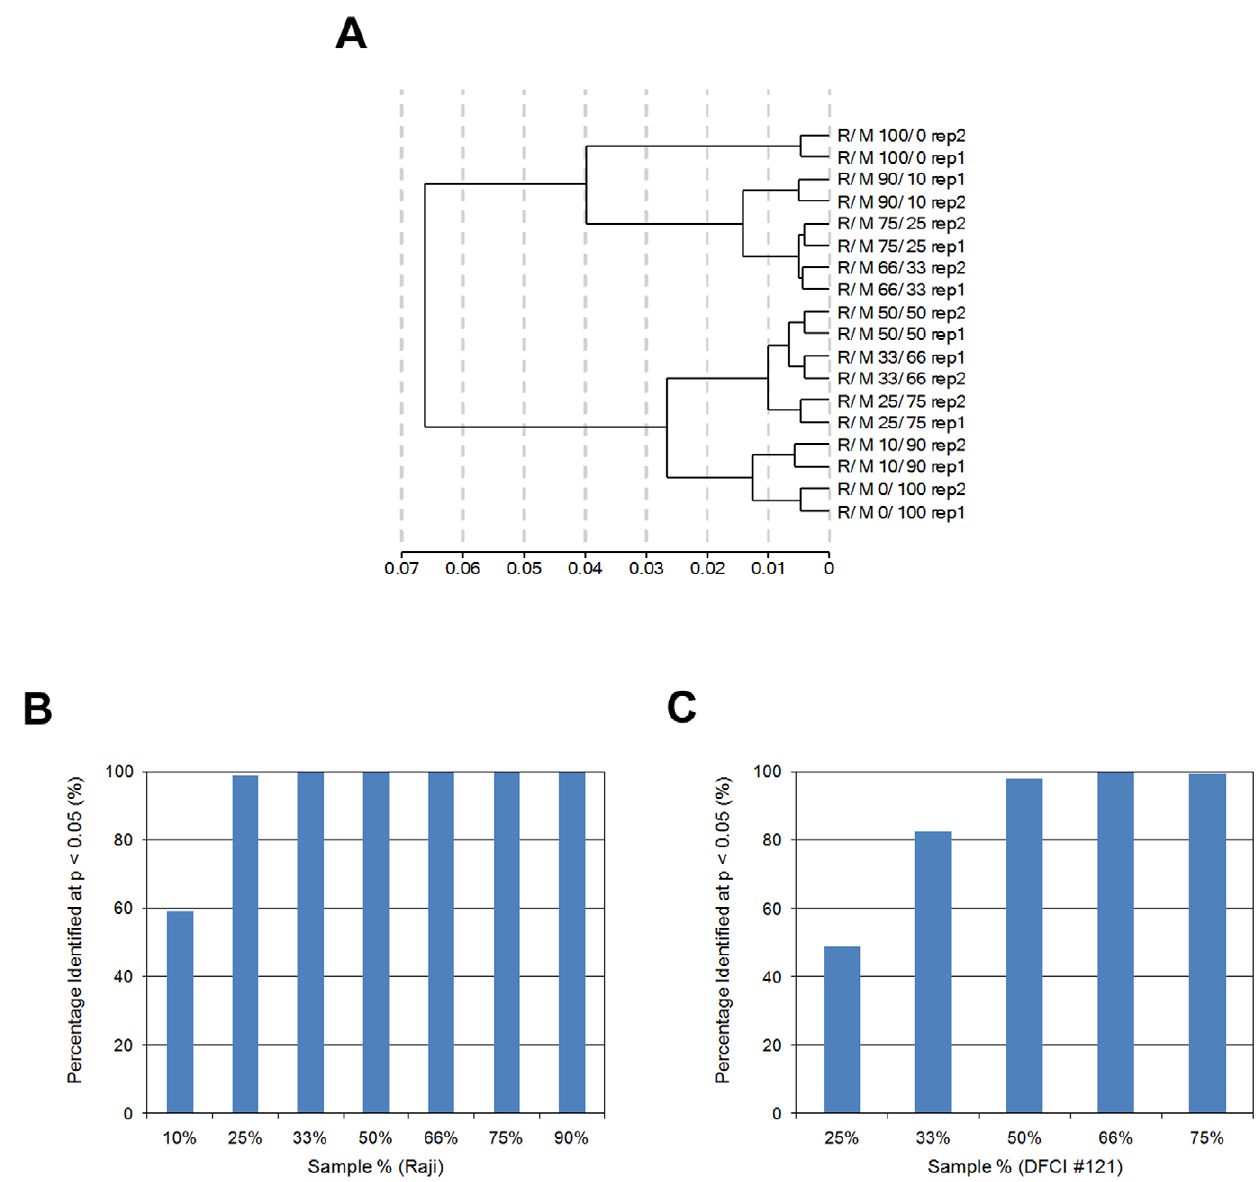
Figure 3. Assay fold-change detection. (A) Total RNAs from Raji (R) and MCF-7 (M) cells were mixed at various ratios, with each mixture having a combined input of 100 ng. After labeling and hybridizing, the raw data underwent unsupervised hierarchical clustering using all 24526 probes shown in the cluster dendrogram. Units on the x-axis are Pearson’s correlation coefficient (R). (B) Using a set of differentially expressed probes, derived from comparisons between the two intact RNA samples (Raji and MCF-7), the number of differentially expressed probes identified in different Raji/MCF-7 mixtures was calculated and plotted as a percentage of that identified in the 100% Raji sample. Values on the x-axis correspond to the percentage of Raji RNA in each mixture, while the values on the y-axis represent the percentage of Raji-specific probes detected in each mixture at p , 0.05. For example, more than 98% of the Raji-specific probes were detected in the 25% Raji mixture (1.3-fold change) and higher Raji mixtures. (C) Using a set of differentially expressed probes, obtained from comparisons between two FFPE samples (DFCI # 121 and DFCI # 123), the number of differentially expressed probes identified in the different DFCI # 121/ # 123 mixtures was calculated and plotted as a percentage of that identified in the 100% DFCI # 121 sample. Values on the x-axis correspond to the percentage of DFCI # 121 RNA in each mixture, while the values on the y-axis represent the percentage of DFCI # 121-specific probes detected in each mixture at p , 0.05. For example, more than 80% of the DFCI # 121-specific probes were detected in the 33% DFCI # 121 mixture (1.5-fold change) and higher DFCI # 121 mixtures. doi:10.1371/journal.pone.0008162.g003 between both FF and FFPE sample sets. For qRT-PCR vs. WG- logs. Comparisons between matched FF and FFPE tissues yielded DASL comparisons we, like others [5], also noted poorer a high degree of profile concordance with a large number of correlations for genes with low array signal intensities, which transcripts robustly detected in both FF and FFPE samples. adversely impacted the overall platform concordance. Despite this Detailed comparisons between normal and tumor FF and FFPE effect we obtained an average fold-change correlation of sample sets yielded significant fold-change correlations of R 2 , 0.70 and . 70% of the differentially expressed transcripts shared R 2 = 0.55, a result which is consistent with that reported for other